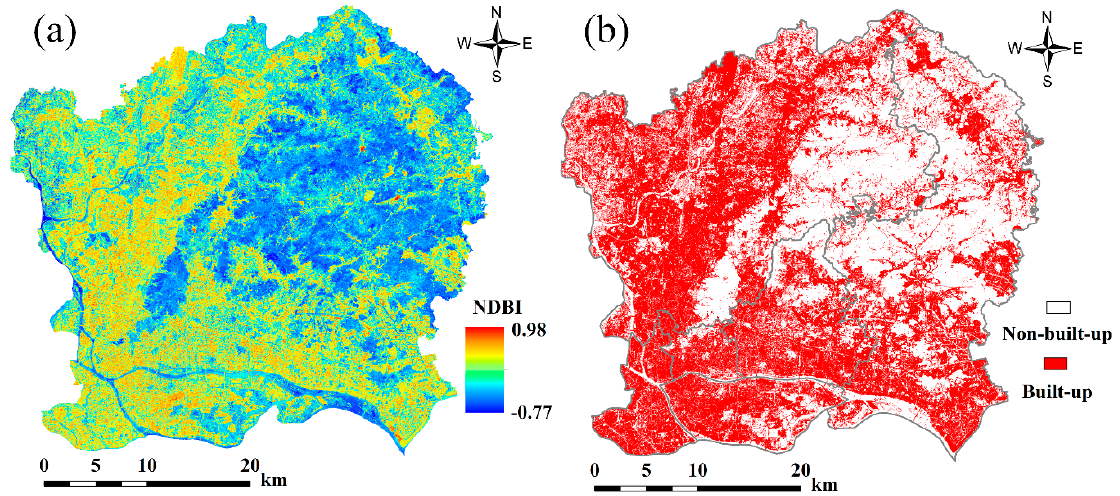
Figure 4. ( a ) Normalized difference built-up index (NDBI; warmer colors indicate a higher index); and ( b ) non-built-up (white) and built-up (red) areas extracted using Otsu’s method.